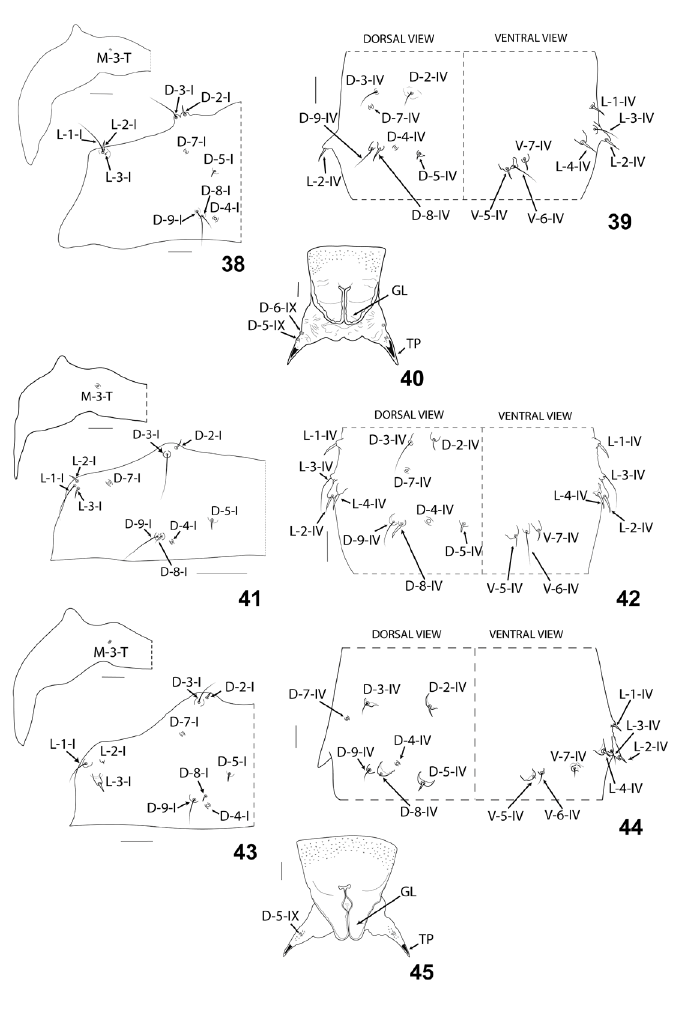
oculars (Fig. 34): O-1-H, O-3-H short, stout setae, O-2-H campaniform sensillum. Cephalothorax rectangular, surface predominantly smooth with small spinules on mesonotum, between bases of respiratory organs. Length of cephalothorax 1.50 mm, width 1.01 mm. Thorax: Respiratory organ (Figs. 20, 22, 36) smooth, pale brown, about 3.77 times longer than broad, with rounded apex, with simple row of 14 pores closely abutting at apex; pedicel slender (Figs. 20, 36), P 0.02 mm; RO length 0.20 mm, RO width 0.05 mm; P/RO 0.10; sensilla: three anteromedials (Fig. 36): AM-1-T, AM-2-T long, stout setae, AM- 3-T campaniform sensillum; one anterolateral